Question: According to this chart, does the measure grow or shrink?
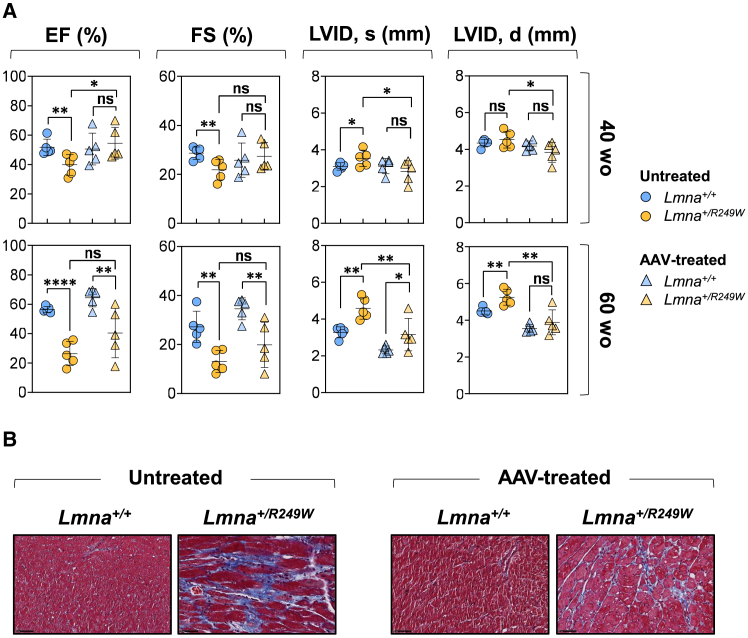
Answer: increasing